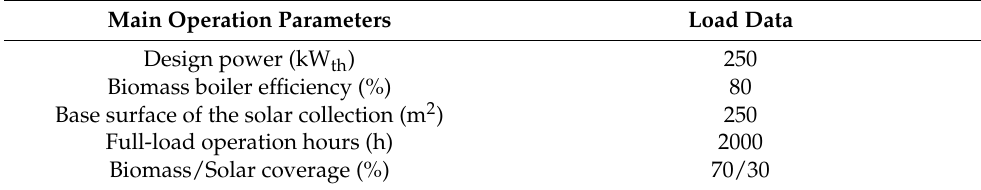
Table 2. Operational parameters of the hybrid-modular system.